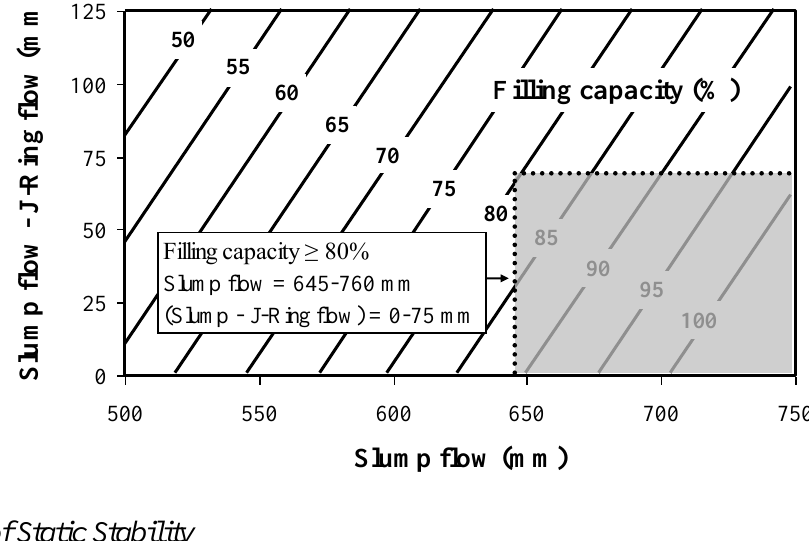
Figure 3. Contour diagrams between filling capacity, slump flow, and (slump flow-J-Ring flow) determined at 10 min (R² = 0.80) (Equation